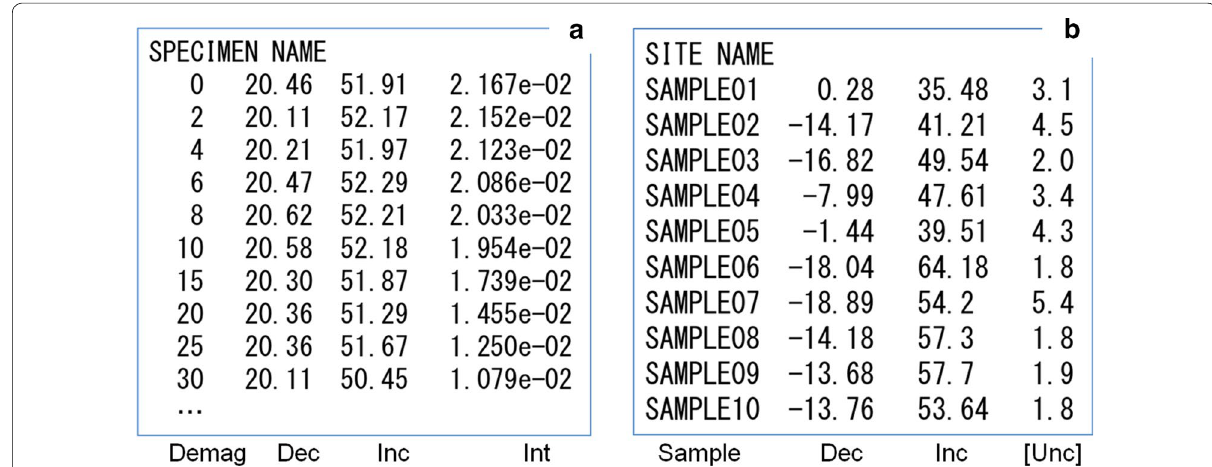
Fig. 1 File format descriptions for a KyotoFormat/P and b KyotoFormat/D. The fourth column (uncertainty of the direction) of KyotoFormat/D is optional. It is not necessary to describe units in each